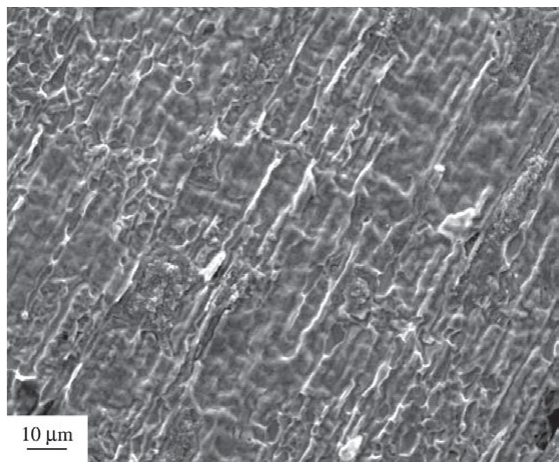
Figure 11. Metal side of the Fe-18Cr-oxide interface after scale separation by the blister test showing pronounced undulation. Oxidation in oxygen at 900 °C, oxide thickness : 1.3 µ